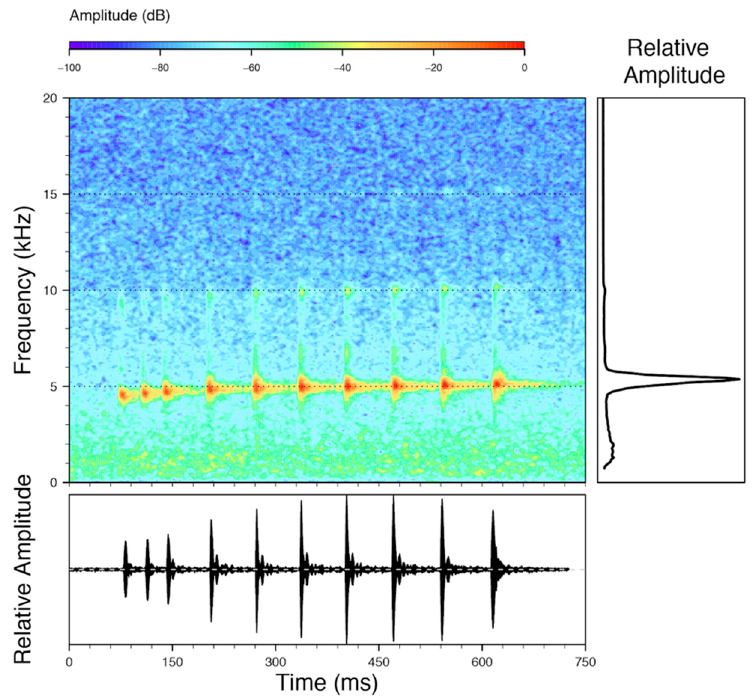
Figure 22. Call of Centrolene ballux from Reserva Las Gralarias, Pichincha province, Ecuador. Tadpole: Not described.